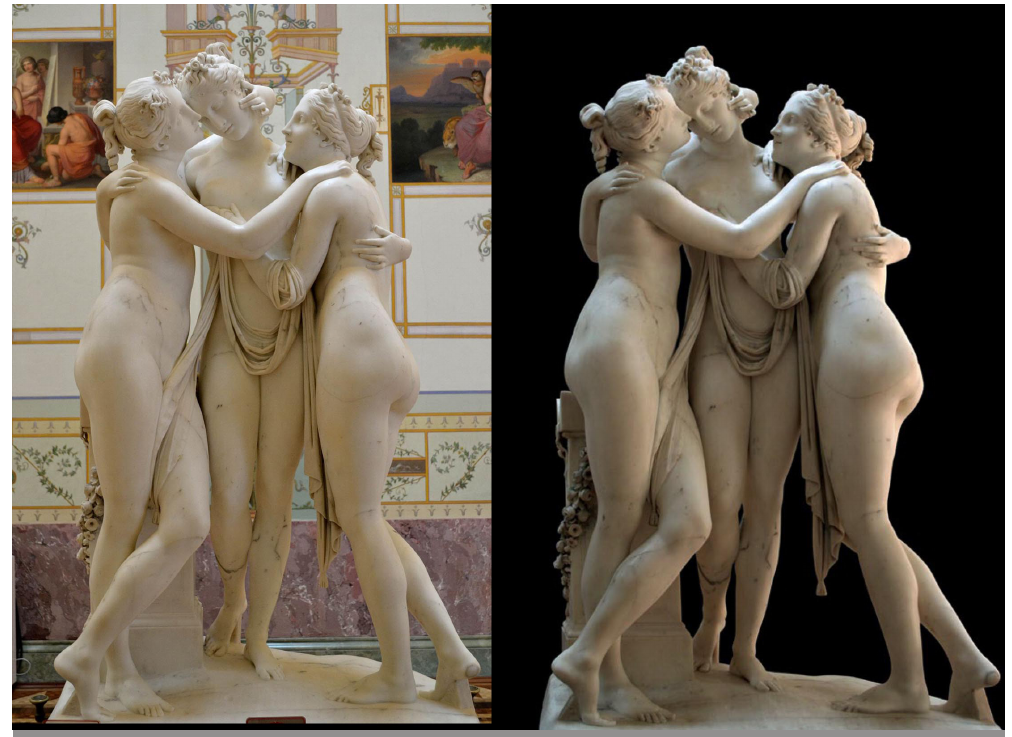
Fig. 7 M. Lo Turco, Le Tre